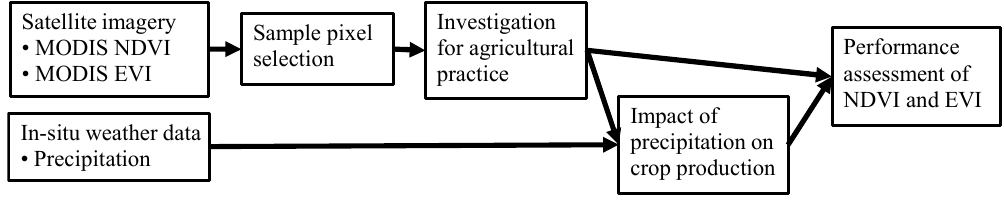
Figure 4. Study flow